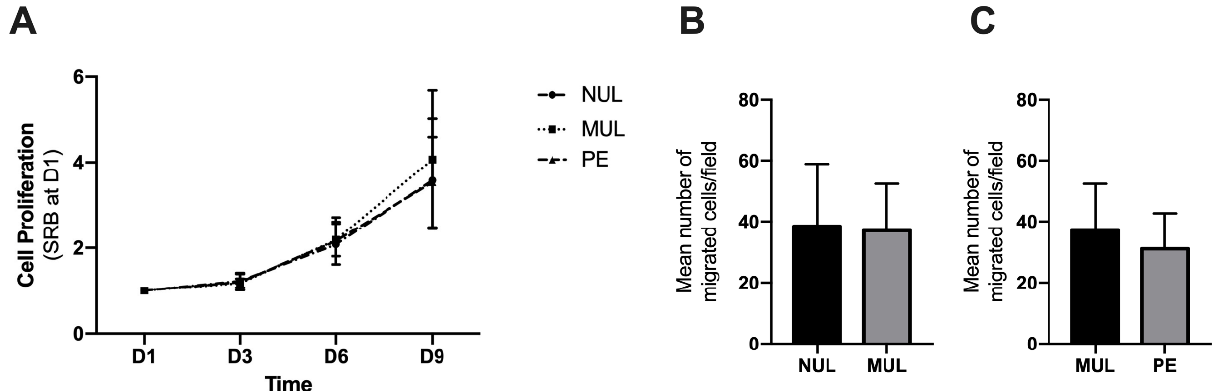
Figure 1. Proliferation and migration of MenSCs derived from nulliparous (NUL), multiparous (MUL) and PE women. ( A ) MenSCs were seeded for SRB assays to quantify cell proliferation at day 3, day 6, and day 9. Results are presented as mean values and SDs of eight MenSCs per group. ( B ) NUL and MUL MenSCs migration assays. ( C ) MUL and PE MenSCs trans-migration assays. Results are presented as mean values and SDs of six MenSCs per group. Statistical analyses were performed with Mann–Whitney tests. MenSCs, mesenchymal stem cells derived from the menstrual fluid; PE, preeclampsia; SD, standard deviation; SRB, sulforhodamine